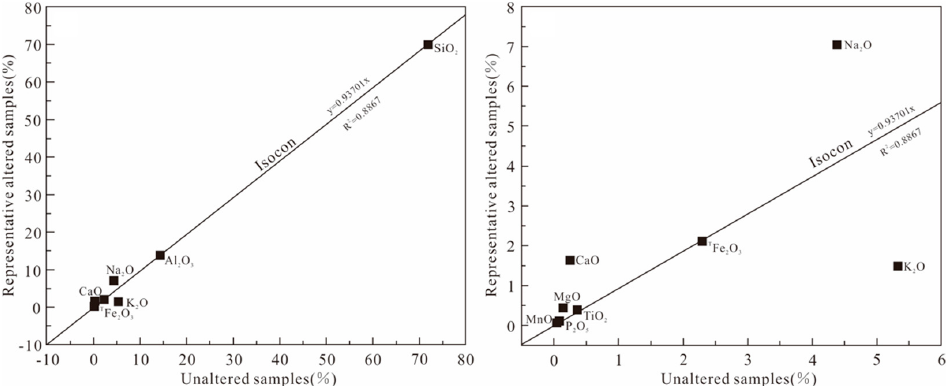
Figure 5. Diagrams for discriminated immobile elements and Isocon curves.